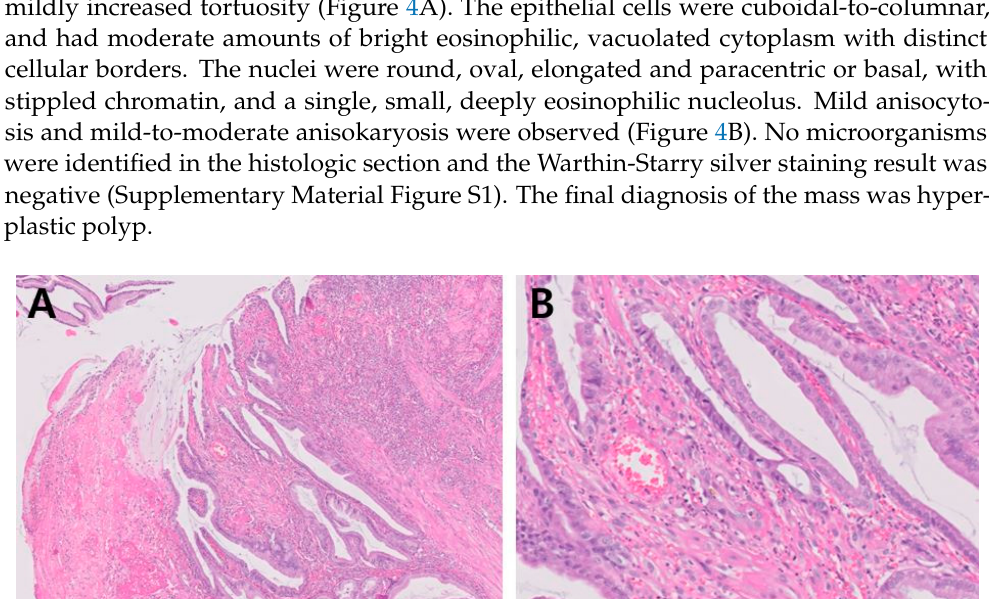
Figure 4. Histopathological sections of the mass (hematoxylin and eosin stain; ( A ): ×100, scale bar = 100 µm, ( B ): ×400, scale bar = 50 µm).